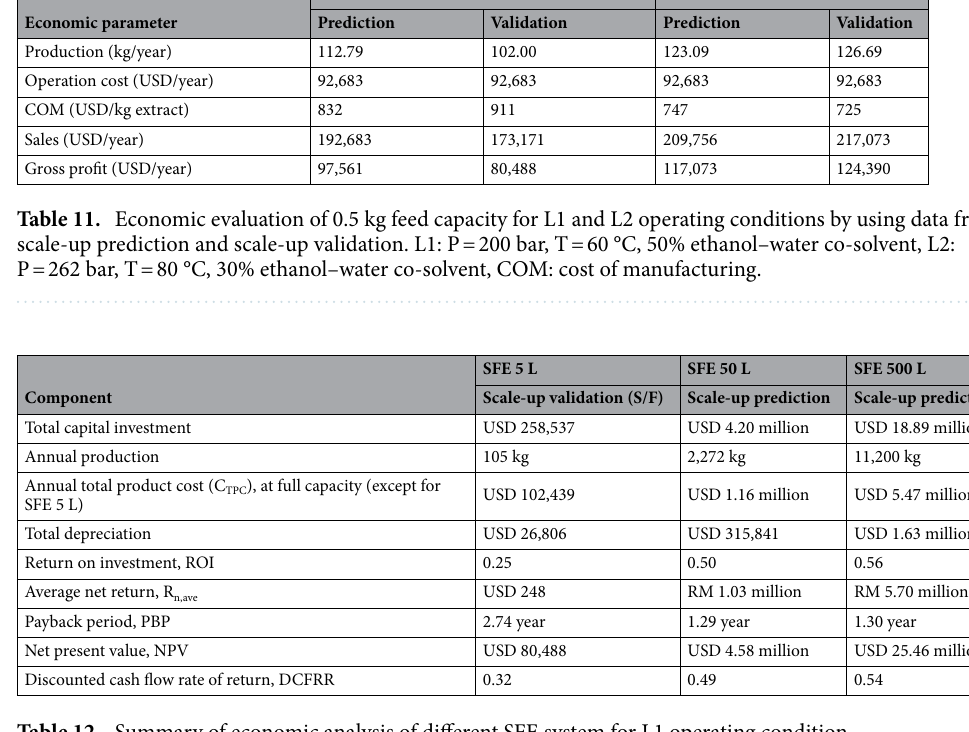
Table 12. Summary of economic analysis of different SFE system for L1 operating condition.